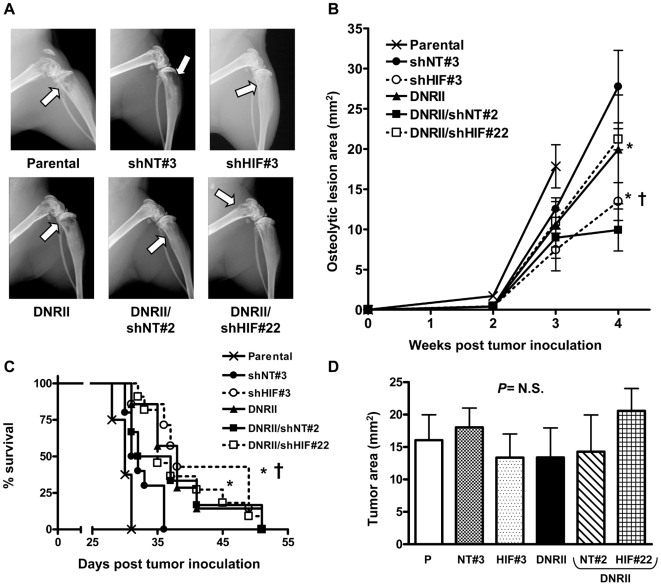
Combined HIF-1α knockdown and TGF-β blockade provides no further benefit in mice with bone metastases.(A) Representative x-ray images from hindlimbs of mice 4 weeks post inoculation with MDA-MB-231 parental, shNT#3, shHIF#3, DNRII, DNRII/shNT#2 and DNRII/shHIF#22 cells. Arrows indicate osteolytic lesions. (B) Osteolytic lesion area measured on radiographs of hindlimbs and forelimbs of mice with bone metastases. Results are expressed as the mean area ± SEM per mouse (n = 6–11 per group). * P<0.001 compared to parental and † P<0.05 compared to shNT#3 using a two-way ANOVA with a Bonferroni post-test at 3 weeks. (C) Kaplan-Meyer analysis of mouse survival. * P<0.001 shHIF#3 and DNRII compared to Parental and † P<0.005 shHIF#3 compared to shNT#3 using a Logrank test. (D) Tumor burden in hindlimbs was measured by quantitative histomorphometry. Results are expressed as the mean ± SEM area per bone. A one-way ANOVA with a Newman-Keuls multiple comparison test showed no significant differences (N.S.) between groups.